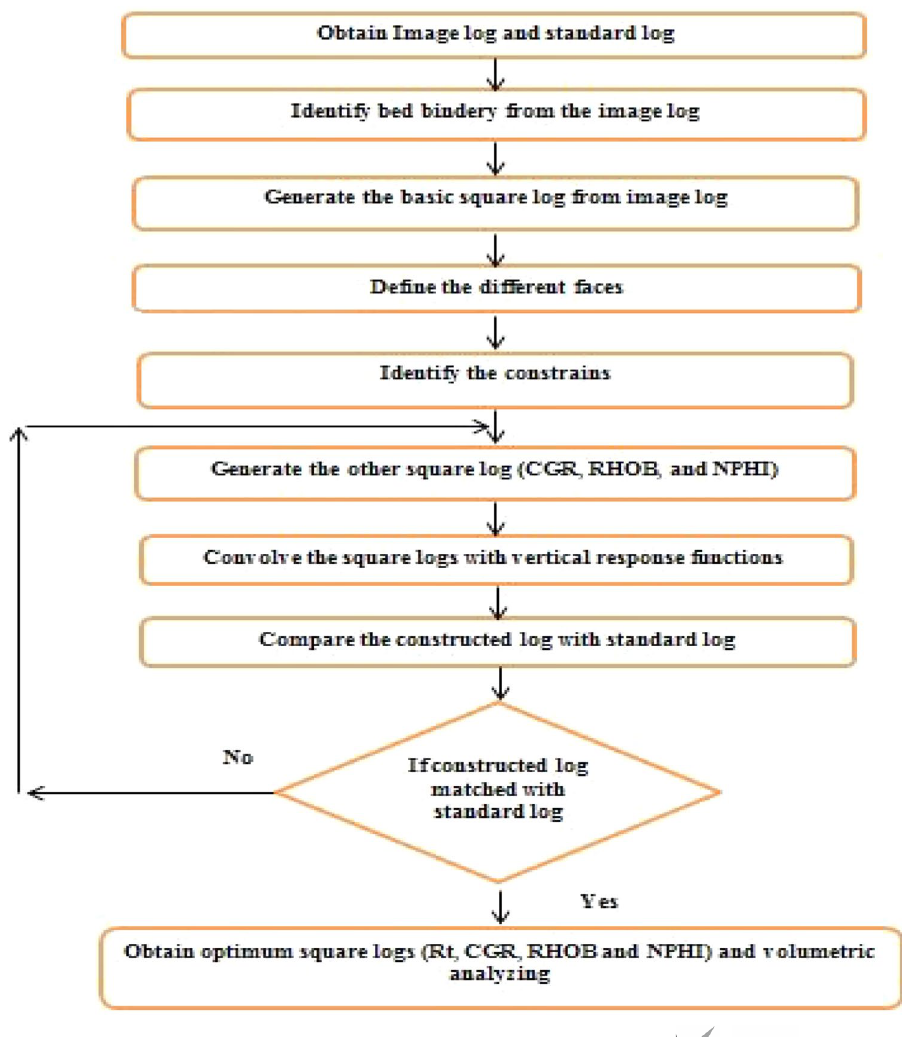
Fig. 10 Workflow diagram for thin-bed analysis with high- resolution